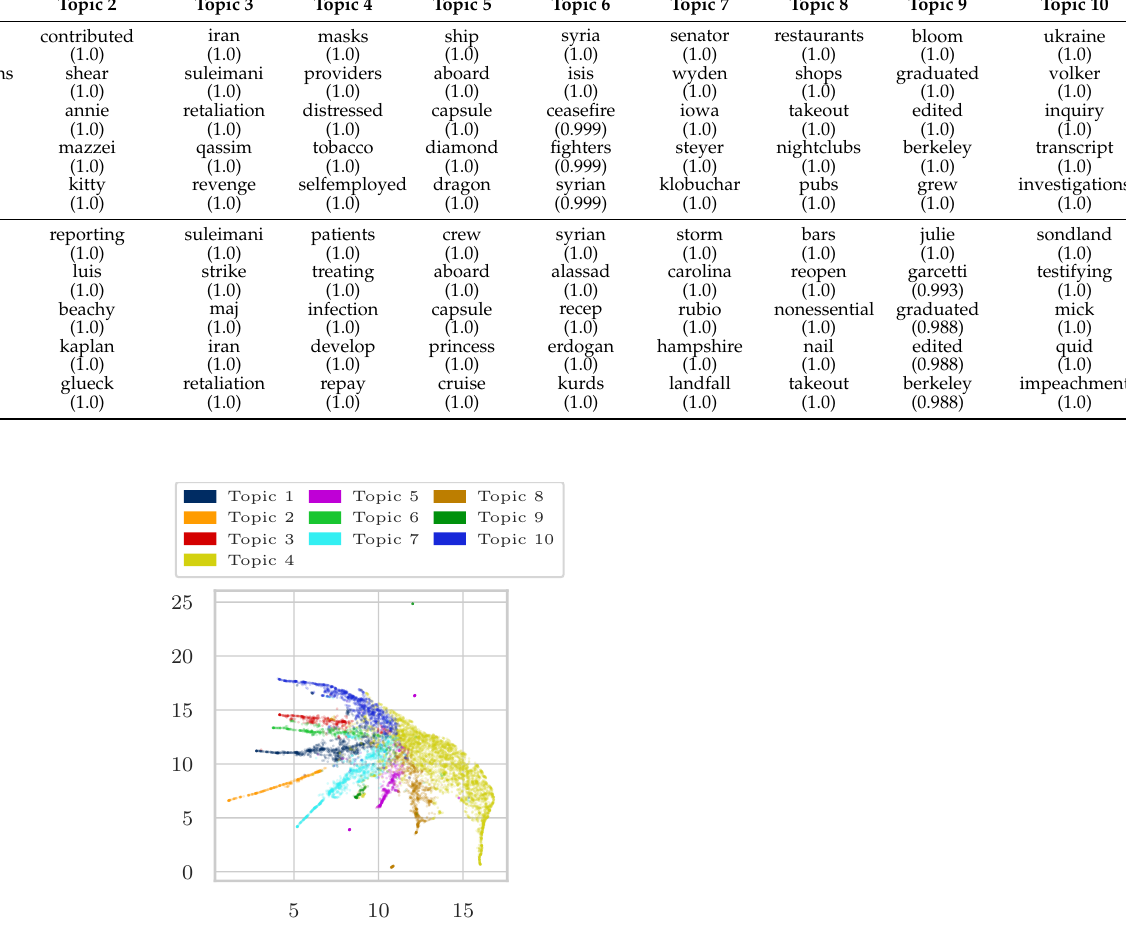
Figure A14. 2-dimensional representation of word embeddings A colored by topic